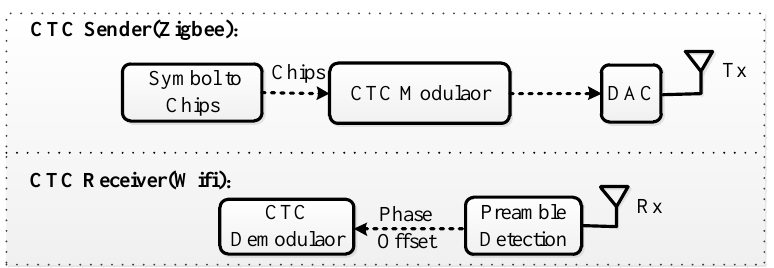
Figure 8. Architecture of high-throughput